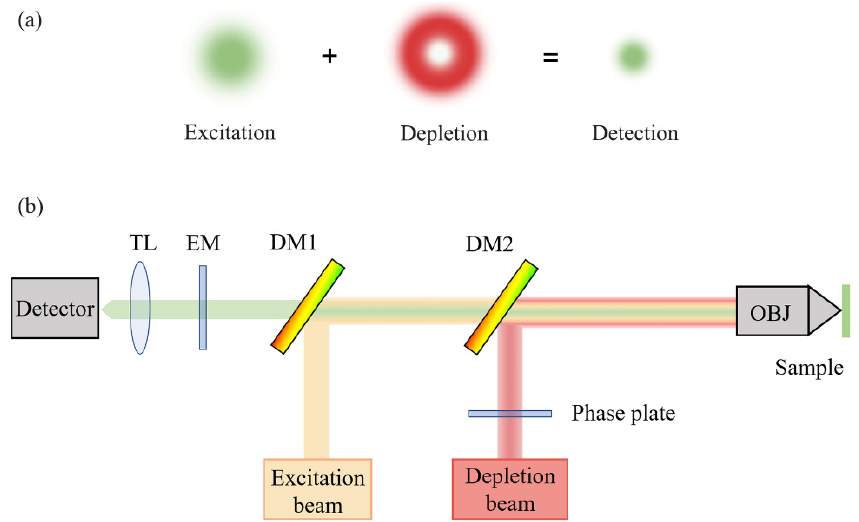
Figure 3. Schematic diagram of STED principle: ( a ) mechanism of the excitation beam and depletion beam; ( b ) optical setup of STED. TL, tube lens; EM, emission filter; DM, dichroic mirror; OBJ, objective lens.